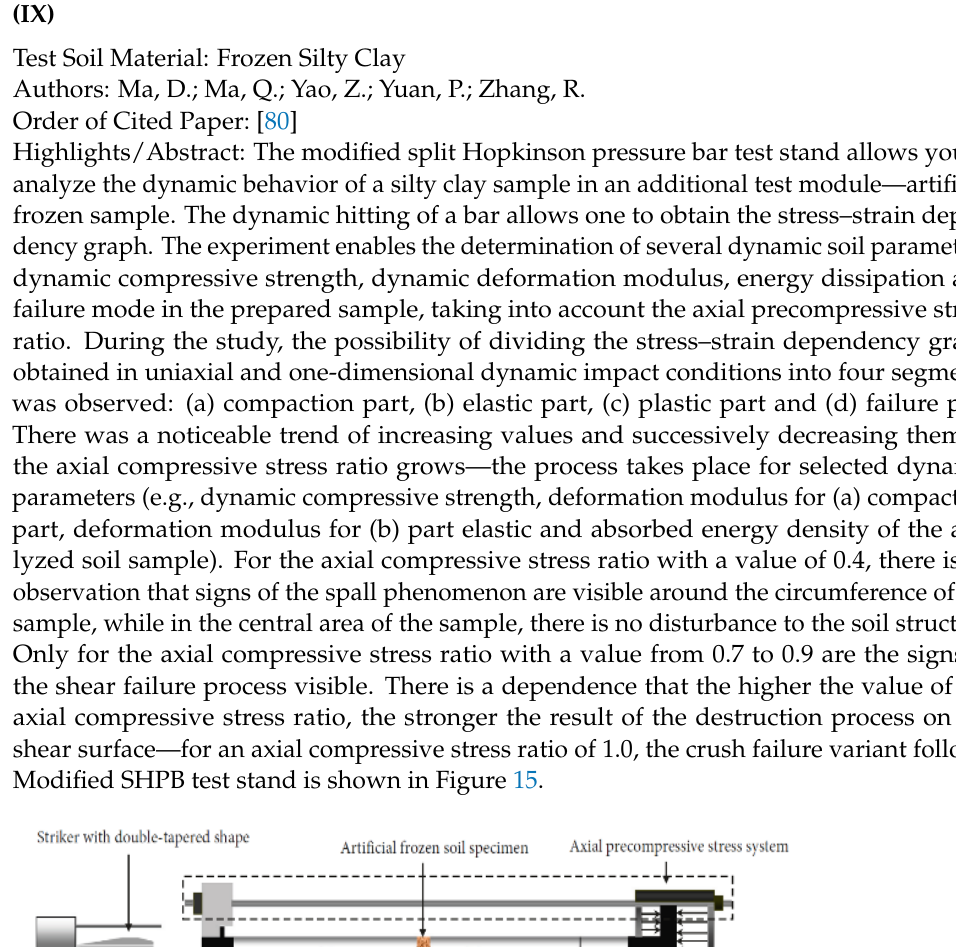
Figure 14. General diagram of SHPB system (reprinted from Ref. [79]).